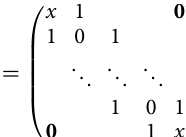
σ are obtained from Eq. (6) ˆ 2.1 . The spectra always A . ( b ) Spectra of A for different values of x and α ˆ ˆ = γ a , 4 γ γ a > 1 . x and out-of-band eigenvalues can occur only for [ + ] | | , 1 ) the spectra are always positive assuring ∈ [−∞ ] 0.001 and T 500 , γ 0 5 , T 1 T a L = = = = =